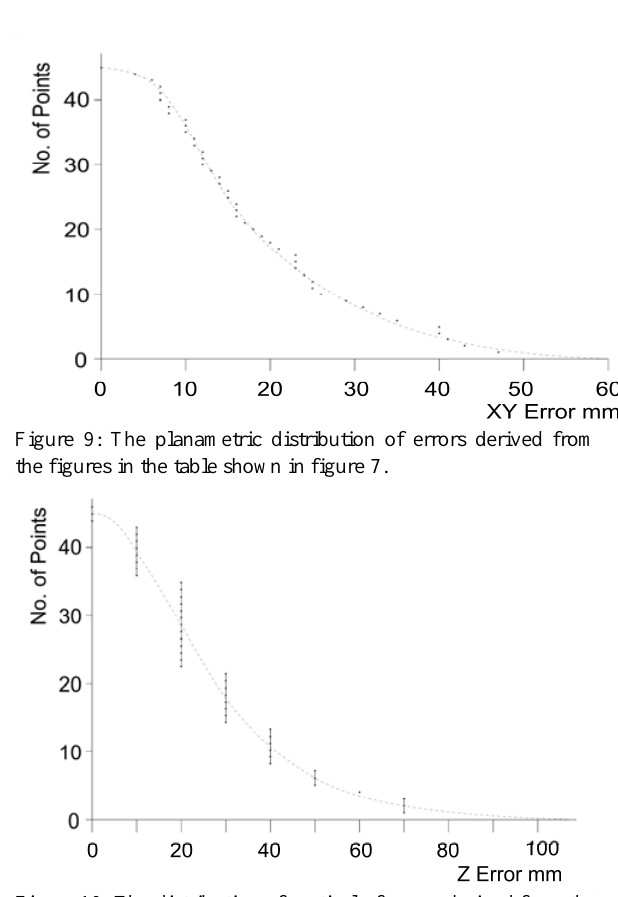
Figure 10: The distribution of vertical of errors derived from the figures in the table shown in figure 7.